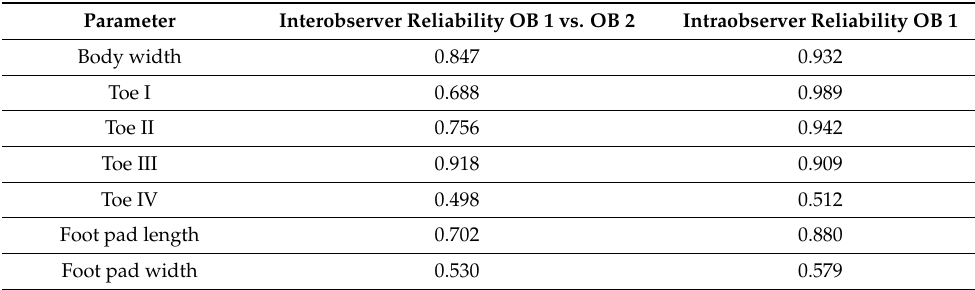
Table 1. Observer reliabilities for the measured body width, toe length, and food pad width and length ( n = 20 birds and 20 feet).